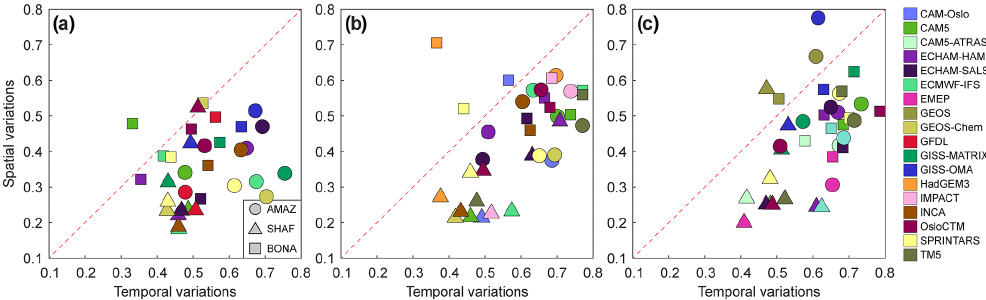
Figure 7. Comparison of the temporal and spatial variations in modeled AOD errors. Results are shown for the three experiments individually ( a BBE, b CTRL16, c CTRL19). All the model data were collocated with POLDER-GRASP. The variation is calculated as the ratio of interquartile to median values of the absolute bias for time series (temporal variations) and spatial averages (spatial variations). The dashed red lines show the 1 : 1